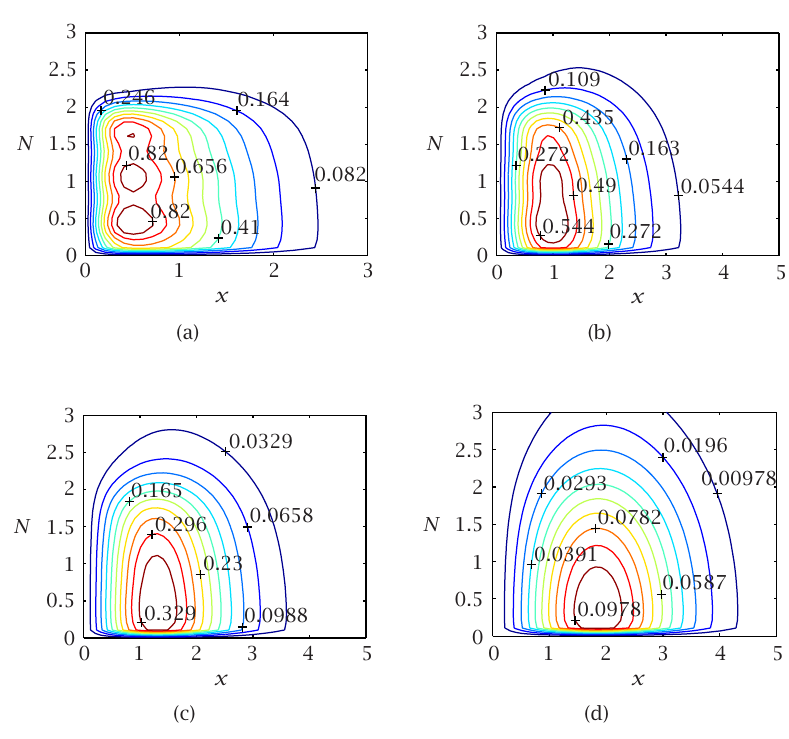
Figure 6.5 . A sample of the results for the computation of the ex- pression for the concentration of dust in the case of a finite vertical source when ν = 0 . 5, b = 0 . 5, and L = 1 . 0 for different times: (a) t = 1 . 0, (b) t = 5 . 0, (c) t = 10 . 0, and (d) t = 20 . 0. Note the slow move- ment of the point of accumulation with increasing